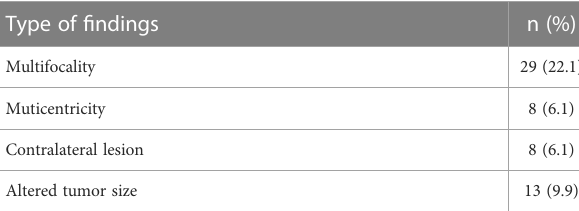
TABLE 2 Breast MRI additional fi ndigns in 131